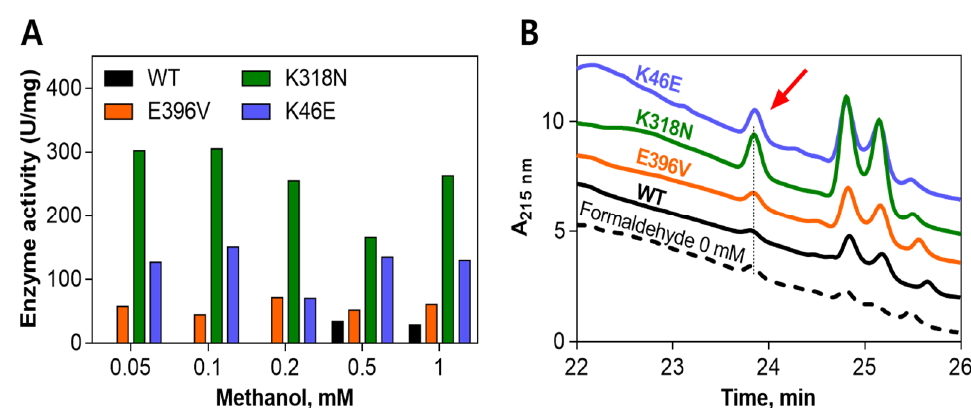
Figure 5. Comparison of enzyme activity among the wild-type and its mutants (E396V, K318N and K46E) by the concentration of generated formaldehyde with respect to methanol concentration ( A ), and the HPLC trace of each sample with 0.05 mM of MeOH as the substrate ( B ). The samples in 40 µL CHES buffer (50 mM, pH 9), containing 0.05 mg/mL protein, 10 mM NAD + , 5 mM of Mg 2+ and methanol (from 0.05 to 1 mM), were incubated at 55 °C for 10 min. The formaldehyde for- mation rate was determined by HPLC as described in the text.